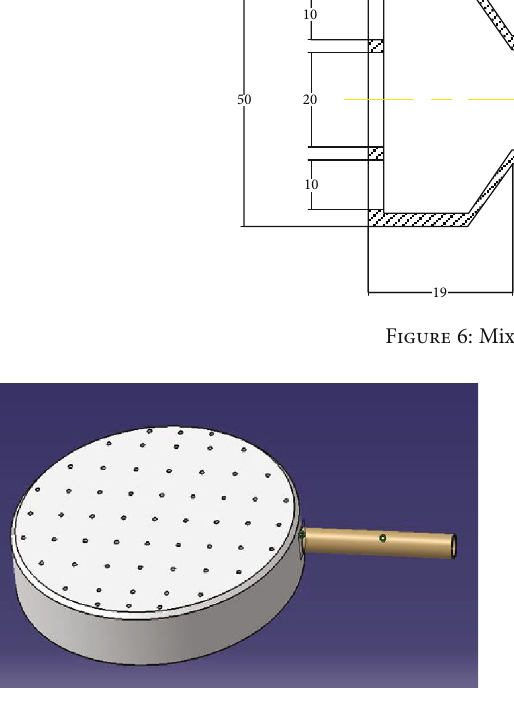
Figure 7: Burner port and gas/air inlet pipe.